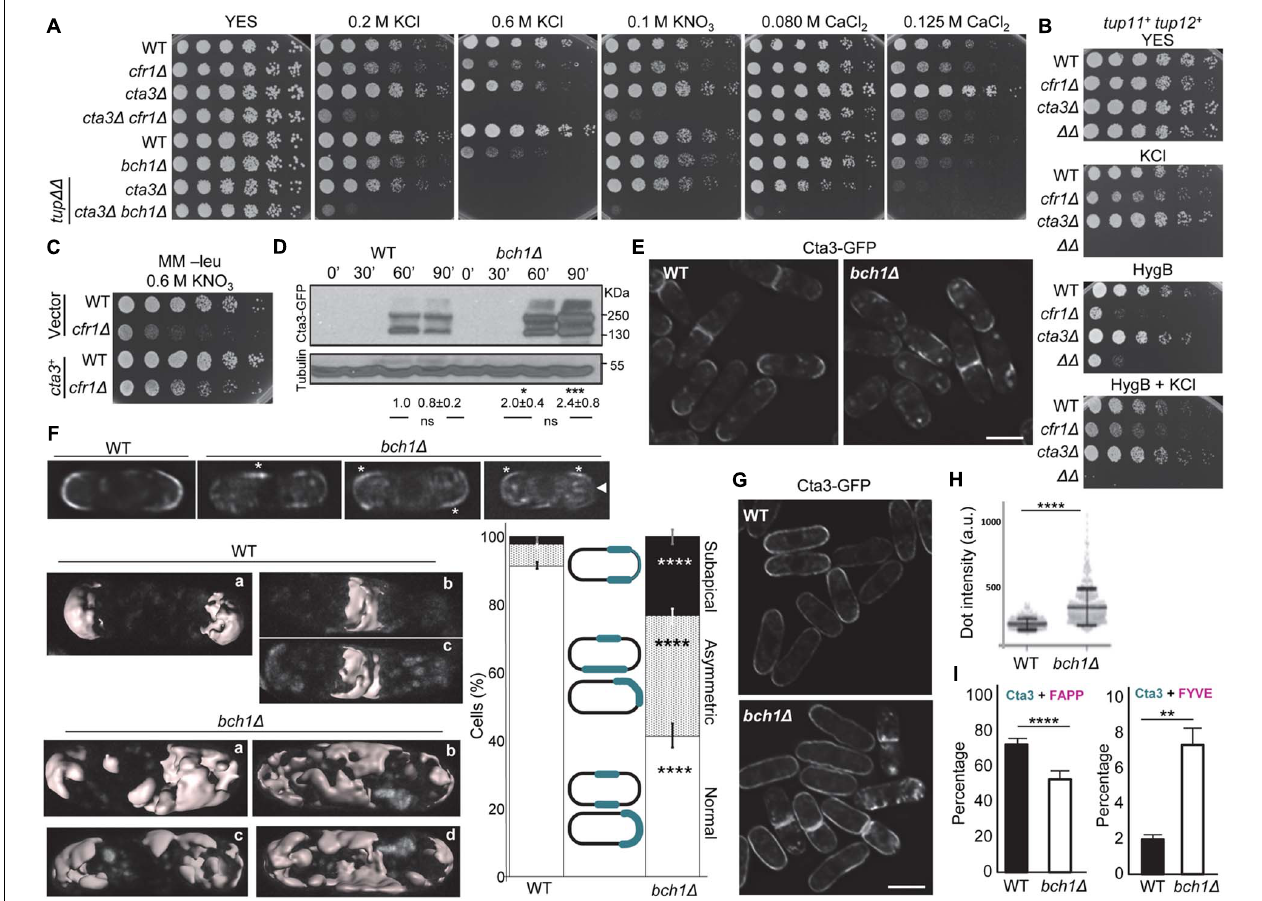
FIGURE 4 | Relationship between exomer and the K + -exporting pump Cta3. (A) Cells from the indicated strains were spotted on YES (rich medium) and YES supplemented with the indicated compounds. tup (cid:49)(cid:49) denoted that the cta3 (cid:49) and cta3 (cid:49) bch1 (cid:49) strains spotted at the bottom of the plate bore tup11 (cid:49) and tup12 (cid:49) deletions. (B) The same experimental details as in (A) , but the cells were inoculated on YES and YES supplemented with 0.4 M KCl, 2.0 µ g/ml hygromycin B (HygB), and 2.0 µ g/ml hygromycin B plus 0.4 M KCl. WT, wild-type; (cid:49)(cid:49) , cta3 (cid:49) cfr1 (cid:49) . (C) WT and cfr1 (cid:49) cells bearing an empty vector or with an integrative plasmid that allows cta3 + expression from the nmt1 + promoter were spotted on minimal medium without leucine (MM -leu) supplemented with KNO 3 and incubated at 32 ◦ C for 5 days. (D) Cell extracts from the WT and bch1 (cid:49) strains bearing Cta3-GFP, incubated in YES before and after adding 0.6 M KCl, were subjected to SDS-PAGE, and were immunoblotted with monoclonal anti-GFP (upper panel) and anti-tubulin (lower panel; loading control) antibodies. The minutes indicate the time of incubation with 0.6 M KCl. The relative position of molecular weight markers is indicated on the right (KDa). The intensity of each Cta3-GFP band was relativized to the value for the corresponding tubulin band, and the values for the mutant were relativized to the value for the WT grown in KCl for the same time. (E) Micrographs of WT and bch1 (cid:49) cells bearing Cta3-GFP after 1 h of incubation in 0.6 M KCl. (F) Upper panel, the same experimental conditions as in (E) . The micrographs show cells with different Cta3 distribution in the plasma membrane. The asterisks denote regions with asymmetrical Cta3 distribution, and the arrowhead denotes a cell pole with subapical Cta3 distribution. Lower left panel, three-dimensional reconstructions of confocal images of the Cta3-GFP distribution in WT and bch1 (cid:49) cells incubated in KCl for 1 h. For the WT, cells with symmetric Cta3 distribution in the cell poles (a) and midzone (b and c) are shown. For bch1 (cid:49) , cells with abnormal distribution at the cell poles (a and c) and midzone (b and d) are shown. Right panel, the graph represents the percentage of WT and bch1 (cid:49) cells with different patterns of Cta3 distribution. The cartoon in the middle represents the different patterns that were scored. (G) The same experimental details as in (E) , but cells were incubated in KCl for 3 h. (H) Dot-plot representation of the fluorescence intensity of intracellular Cta3-GFP dots in WT and bch1 (cid:49) cells captured in three independent experiments. a. u., arbitrary units. (I) Quantification of the colocalization of Cta3-GFP and the TGN marker mCherry-FAPP (left panel) or the PVE marker mCherry-FYVE (right panel) in the WT and bch1 (cid:49) strains. The images in (E–G) , were acquired with a DeltaVision system and are SUM projections. Bar, 10 µ m. In (F,H,I) , the cells were incubated in 0.6 M KCl for 1 h. For each value, the mean of three independent experiments, standard deviation, and statistical significance of the difference, are shown (* p < 0.05; ** p < 0.01; *** p < 0.001; **** p < 0.0001). The statistical differences were determined using Tukey’s